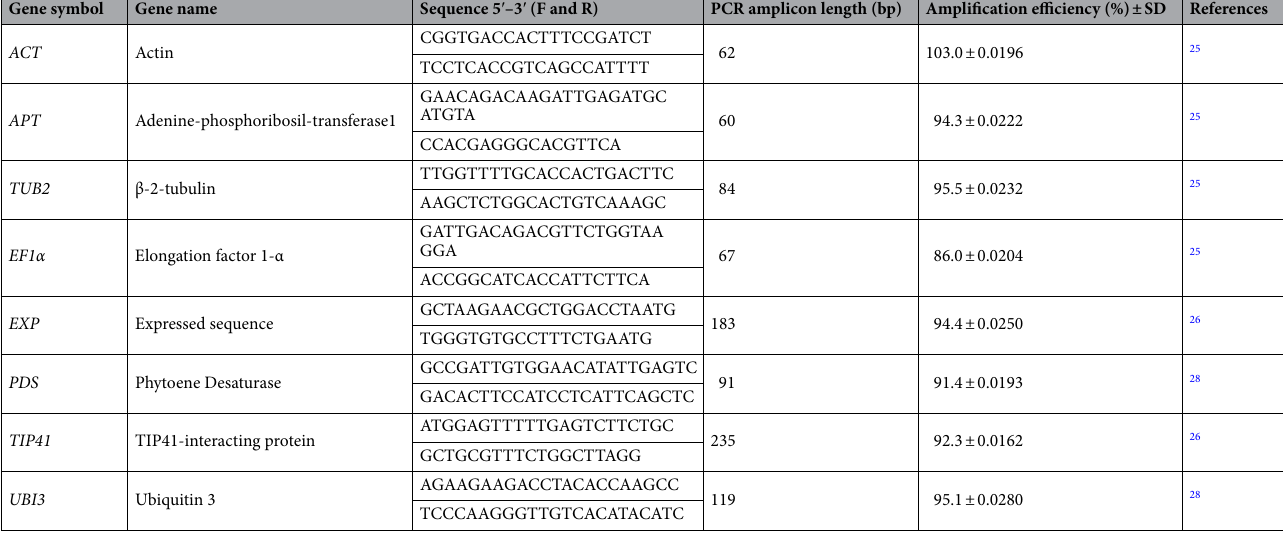
Table 3. Supporting information on the selected primer pairs and amplification profiles of the candidate reference genes for reverse transcription-quantitative PCR (RT-qPCR) normalization involving the pathosystem tomato ‘Hawaii 7996’ and compatible/virulent and incompatible/avirulent Ralstonia solanacearum